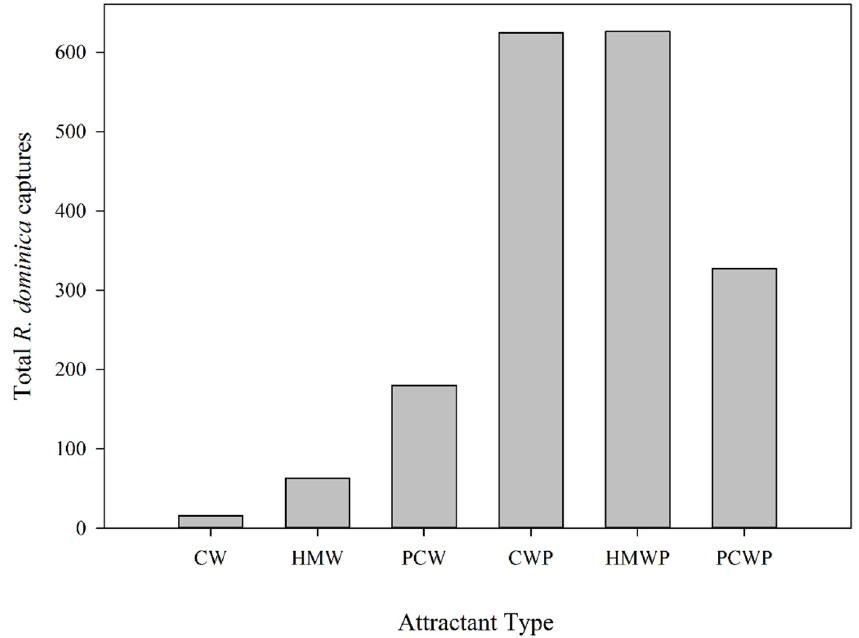
Figure 7. Total Rhyzopertha dominica captures over two years and three locations (native prairie, feed mill, and grain elevator) amongst six different attractants. (CW: crimped wheat; HMW: high moisture wheat; PCW: preconditioned wheat; CWP: crimped wheat plus pheromone; HMWP: high moisture wheat plus pheromone; PCWP: preconditioned wheat plus pheromone).